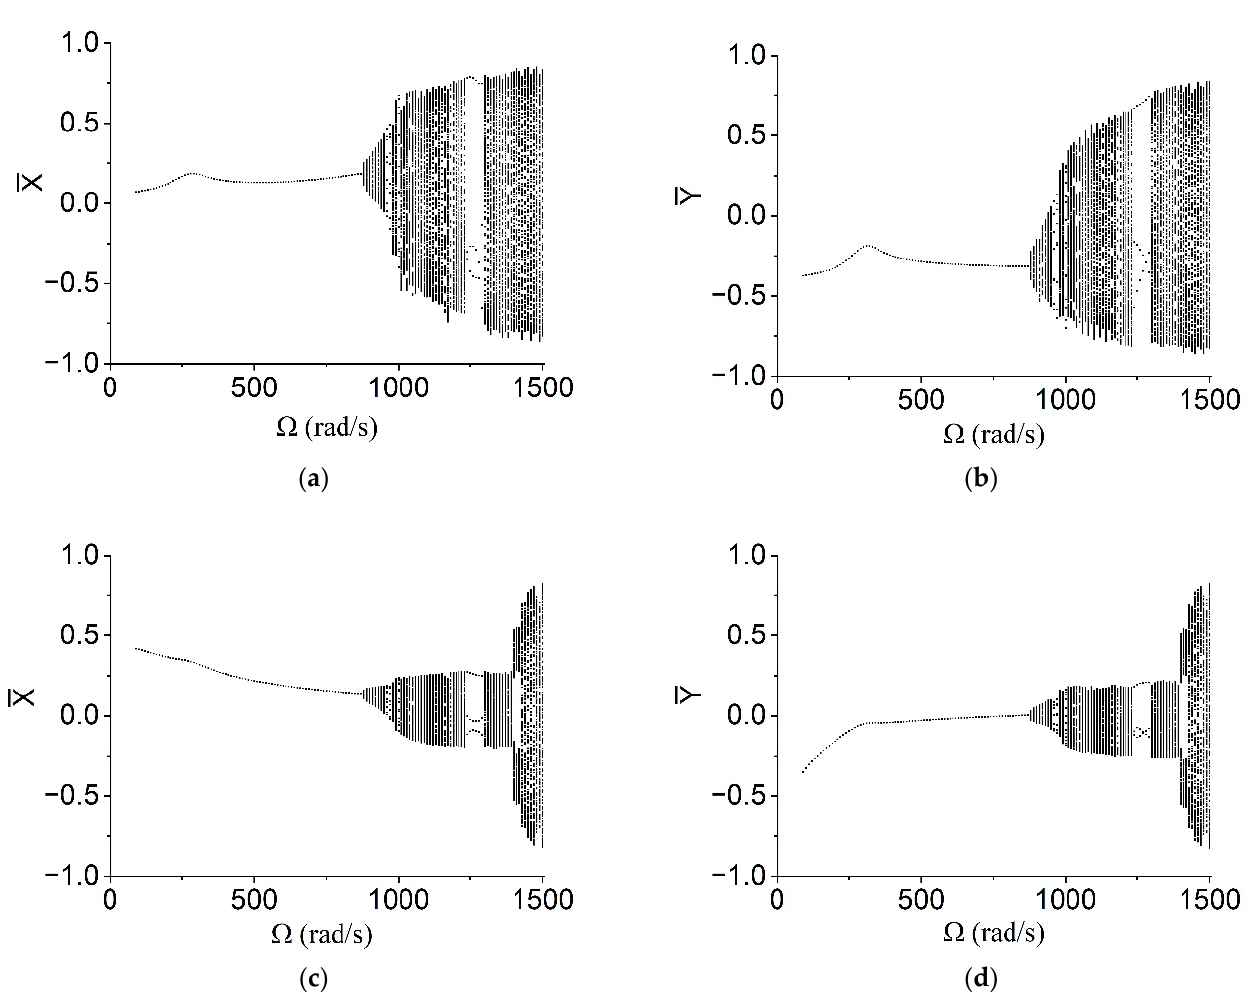
Figure 10. The bifurcation maps of displacements of the VP method: ( a ) X-displacement of rotor; ( b ) Y-displacement of rotor; ( c ) X-displacement of bearing; ( d ) Y-displacement of bearing.